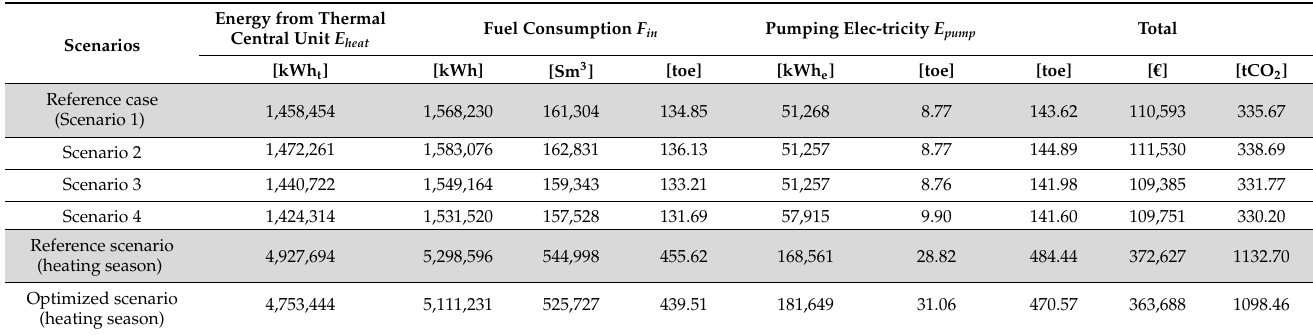
Figure 10. Relative changes from the reference case/scenario, in terms of supplied thermal energy (blue), electricity for pumping (orange), overall operating sources (grey), cost (yellow), and CO 2 emissions (light blue). Table 4. Energy, economic and environmental assessment (in grey field those considered as reference for the comparative